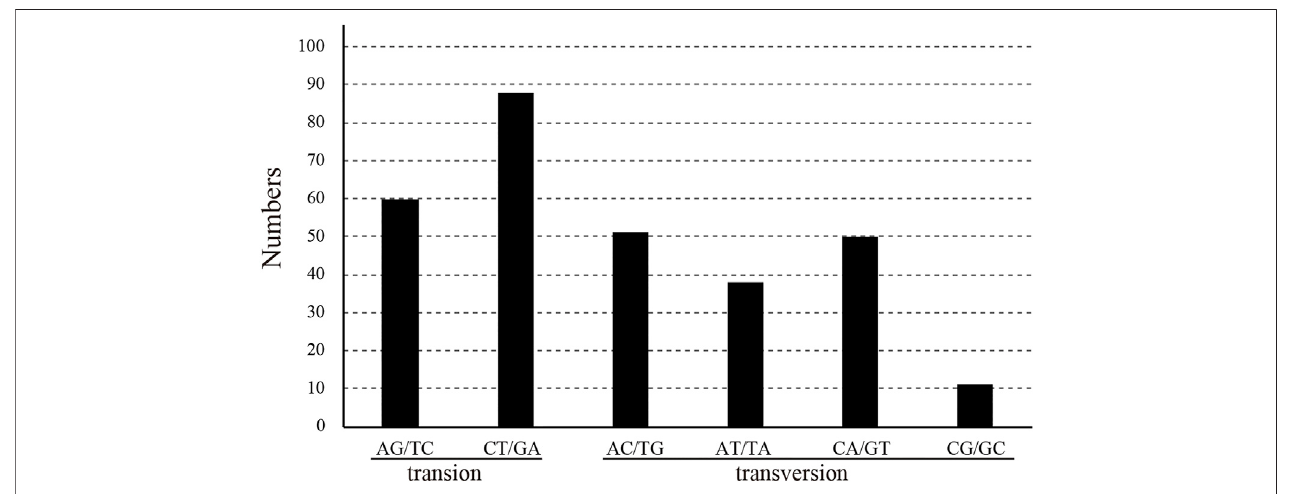
FIGURE 5 | Pattern of single-nucleotide substitutions in the six Catalpa chloroplast genomes.